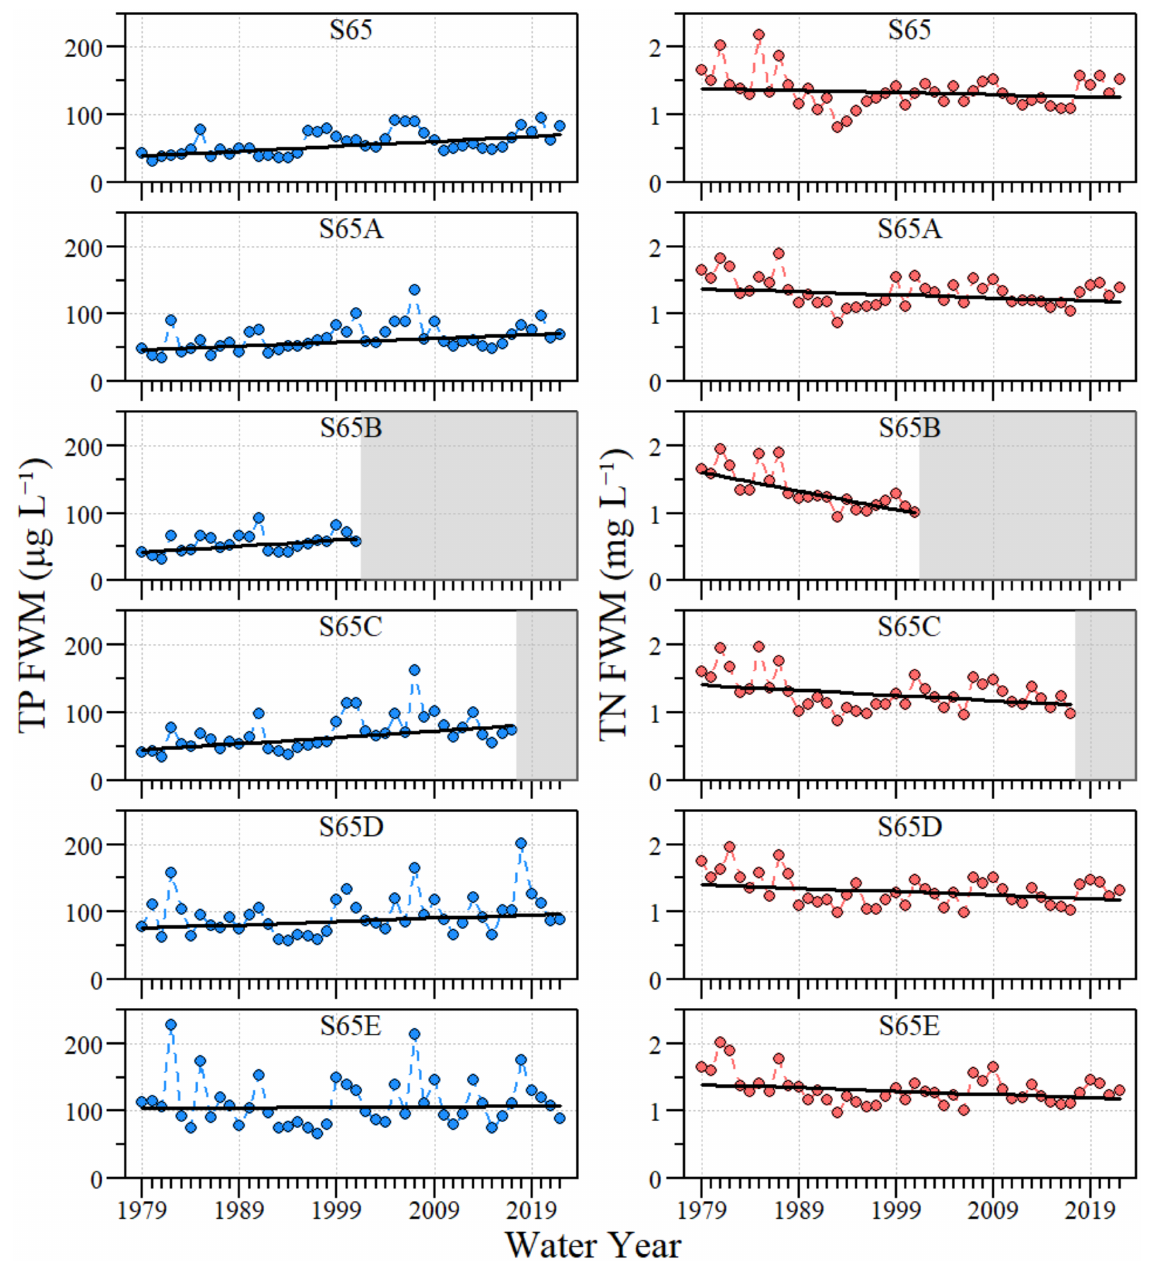
Figure 3. Total phosphorus (TP) and total nitrogen (TN) annual flow-weighted mean concentration for each structure along the Kissimmee River floodplain from water year (May–April) 1979 to 2022. The black line through each time-series indicates the monotonic trend in annual values for each respective structure and parameter. Grey-shaded areas for S65B and S65C indicate when the structures were removed as part of restoration